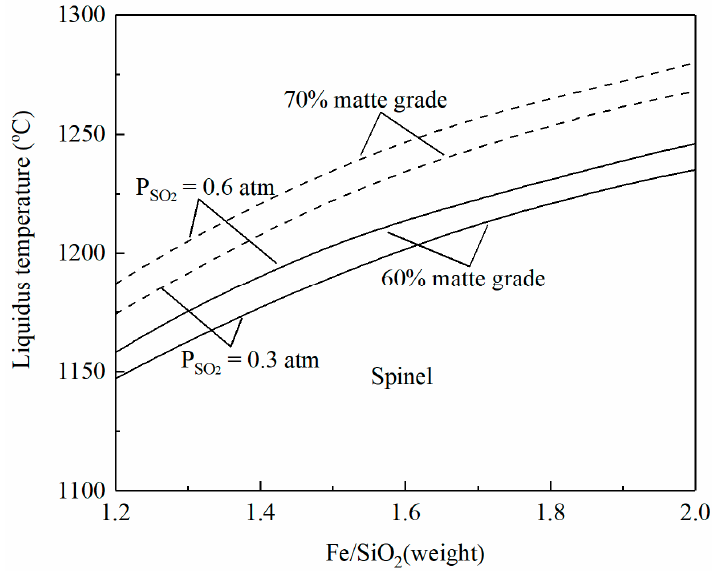
Figure 3. Effects of the Fe/SiO 2 ratio on liquidus temperature of smelting slag, predicted by FactSage 8.2.